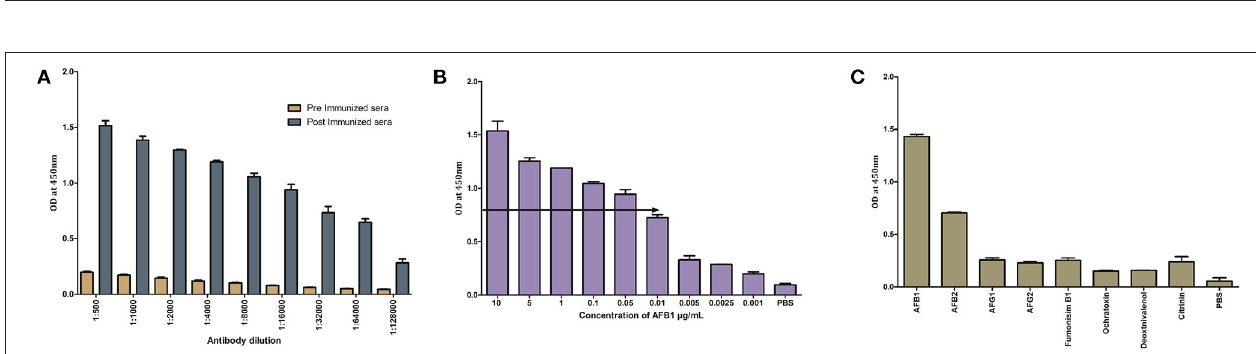
FIGURE 4 | Characterization of generated anti- AFB1 antibody. (A) Indirect ELISA titre value determination of anti-AFB1 antibody. (B) Anti-AFB1 antibody limit of detection analysis against different AFB1 concentration (10–0.001 µ g/mL) by indirect ELISA. (C) Cross specificity analysis of anti-AFB1 antibody against 1-AFB1, 2-AFB2, 3-AFG1, 4-AFG2, 5-Ochratoxin A, 6-Citrinin, 7-DON, 8-FB1, 9 PBS.